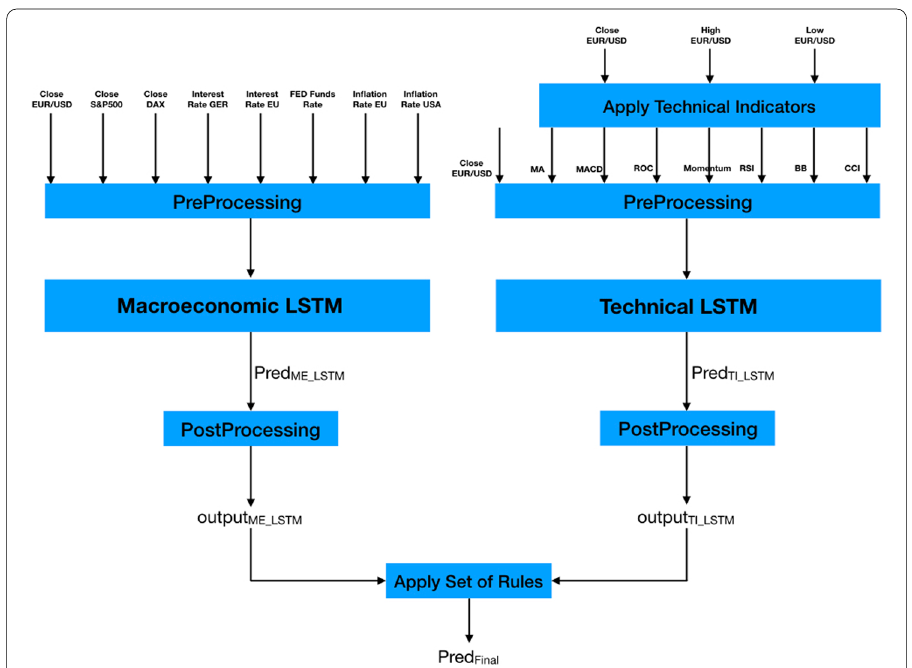
Fig. 2 Hybrid LSTM Model. The macroeconomic LSTM model is on the left, and the technical indicator LSTM is on the